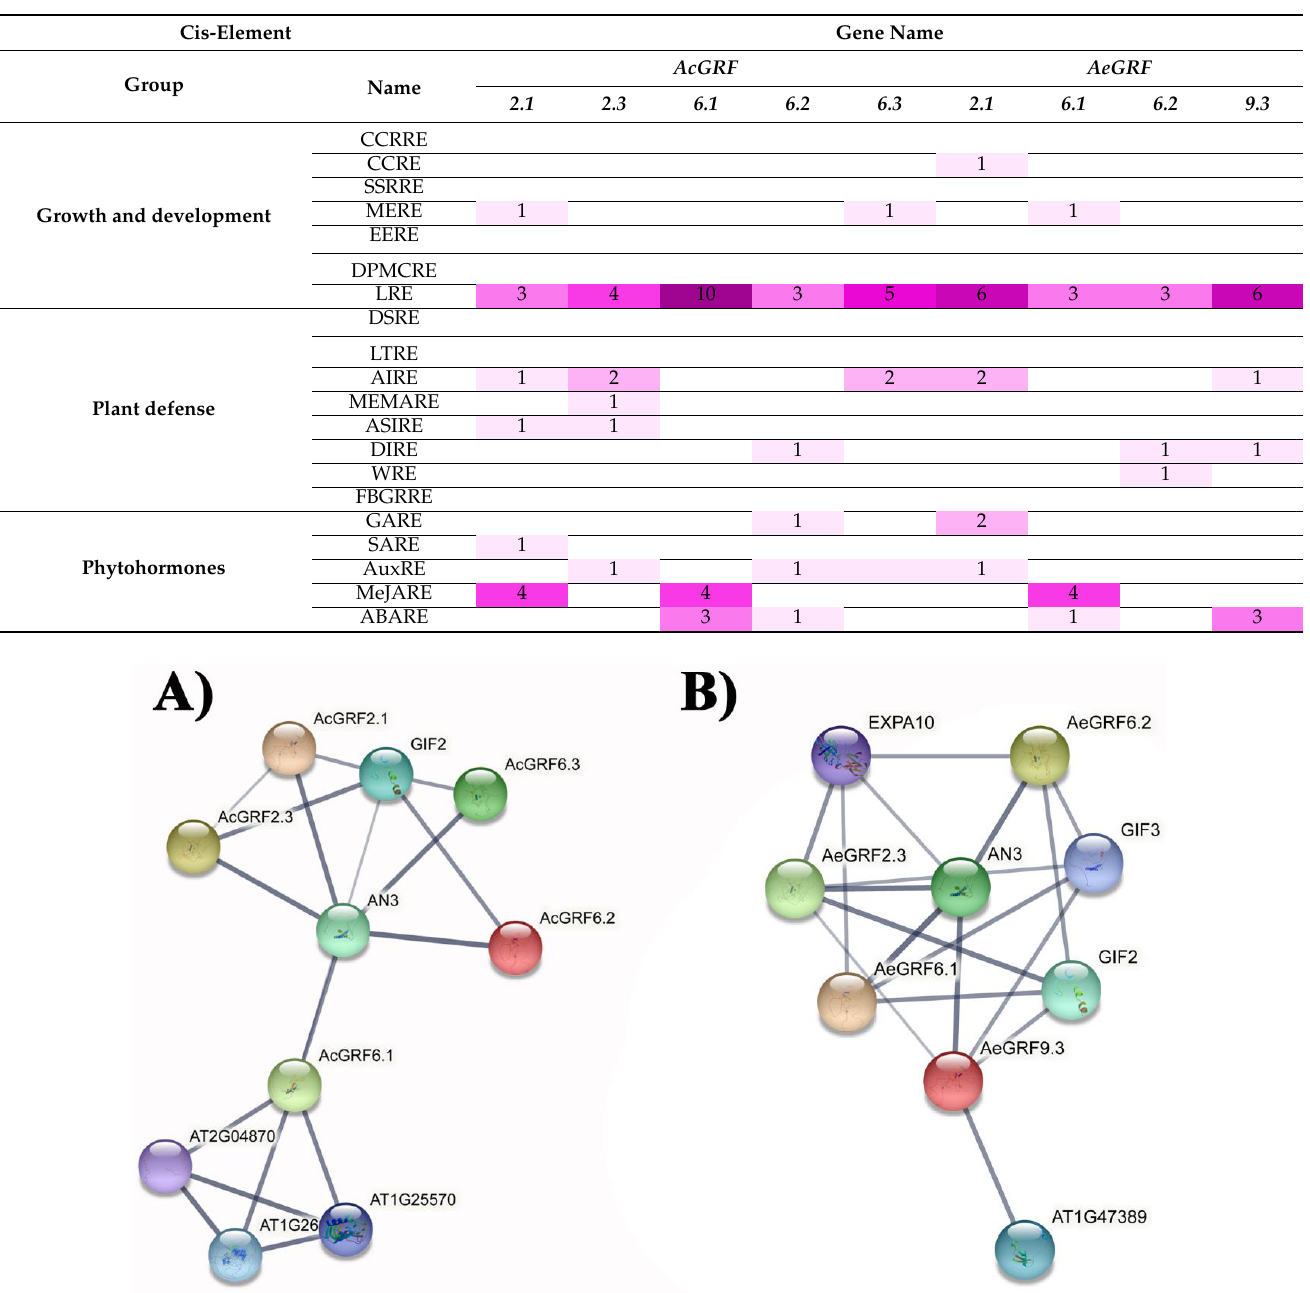
Table 1. Prediction of cis-regulatory elements in the upstream promoter region of nine highly expressing kiwifruit GRFs from different RNA-seq datasets of kiwifruits. A list of full names for acronyms is added in Table S4.